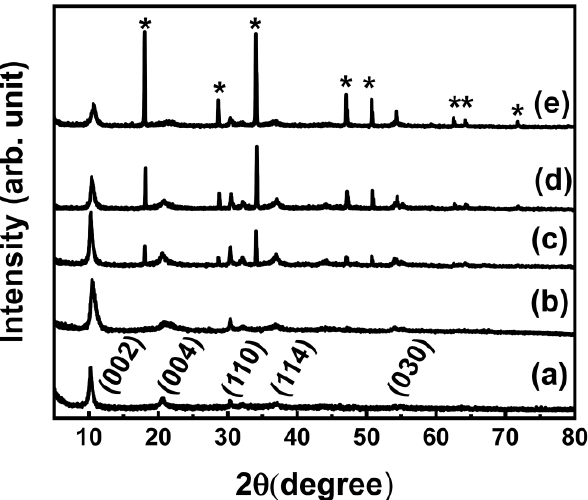
Table 1. Structural parameters of the synthesized materials.